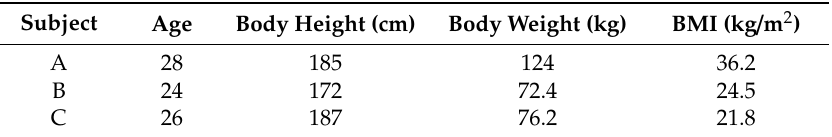
Table 1. Demographic data of the participants.